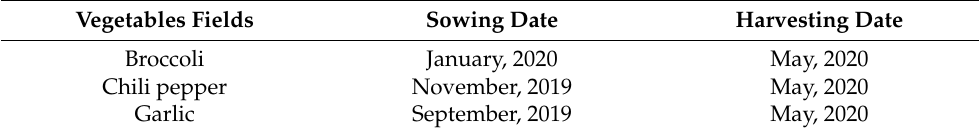
Table 1. Sowing and harvesting dates of broccoli, chili pepper and garlic in the experiment. Vegetables